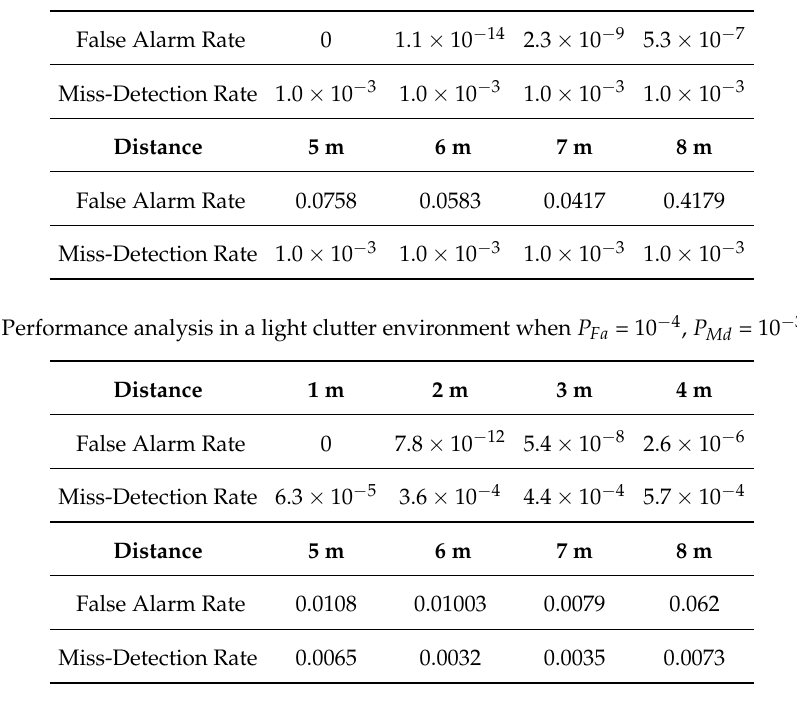
Table 3. Performance analysis in a light clutter environment when P Fa = 10 − 4 , P Md = 10 − 3 , α = 0.5.